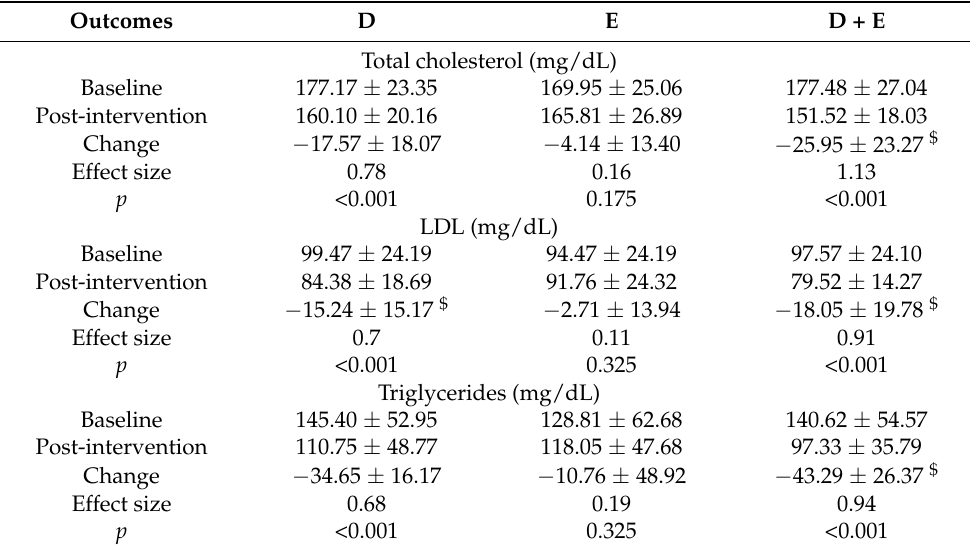
Table 4. Improvements in blood biochemistry values after the 12-week intervention.